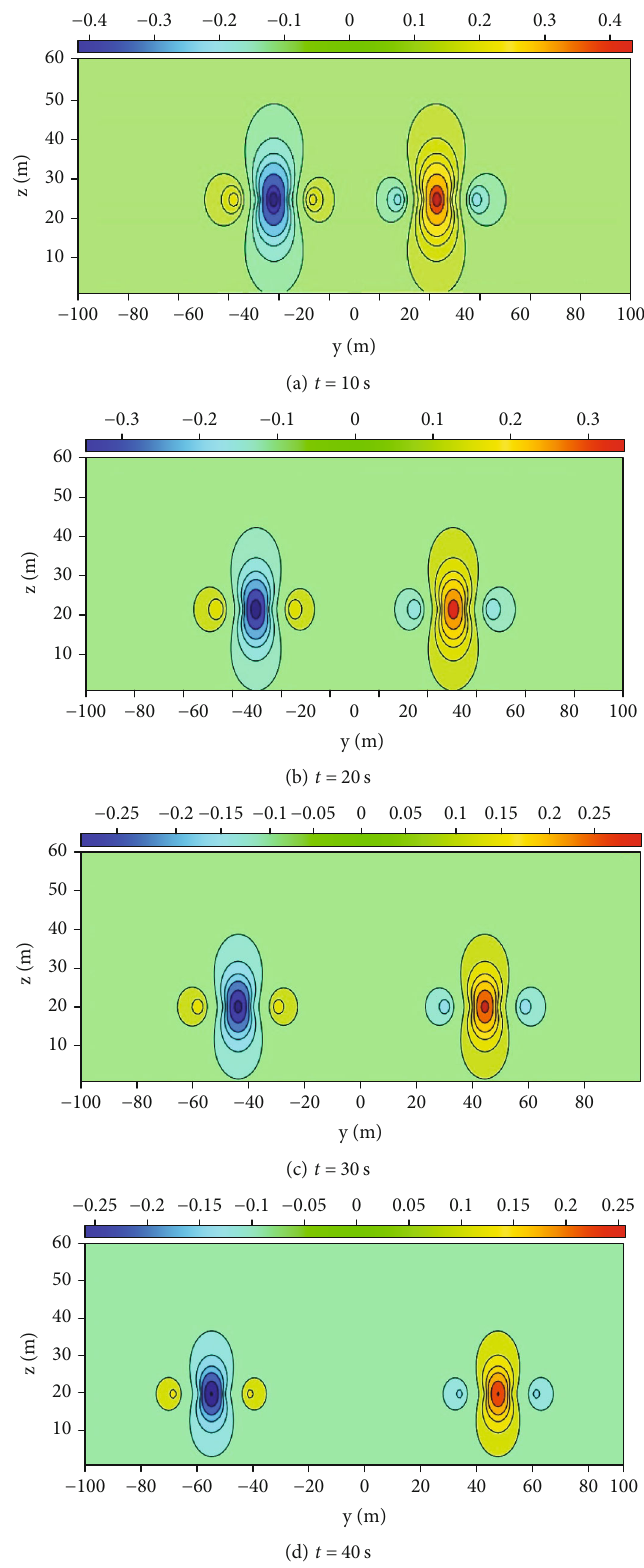
Figure 19: Variation in the wake roll hazard zone with time at the 30-m